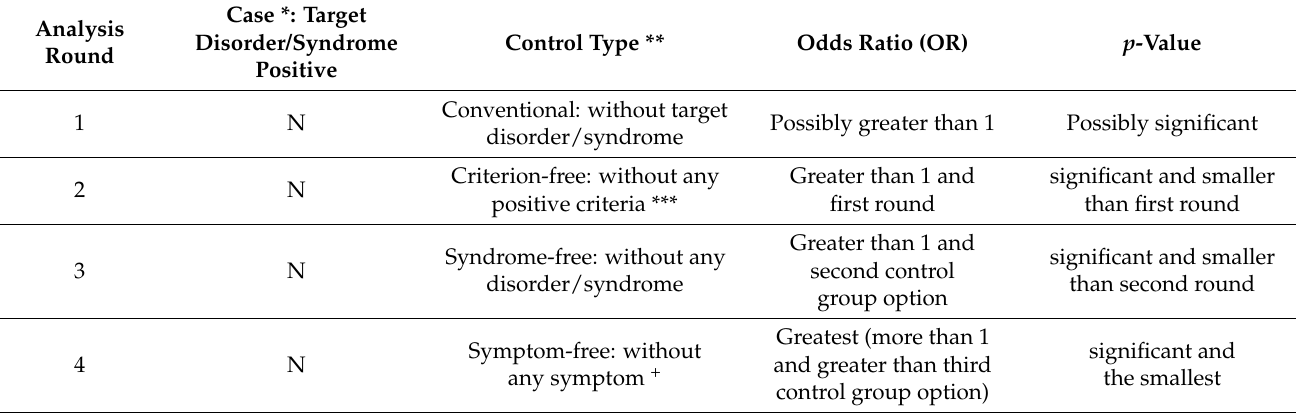
Table 1. Theoretical effect of different control group selection on impact size of the analysis in functional disorders.